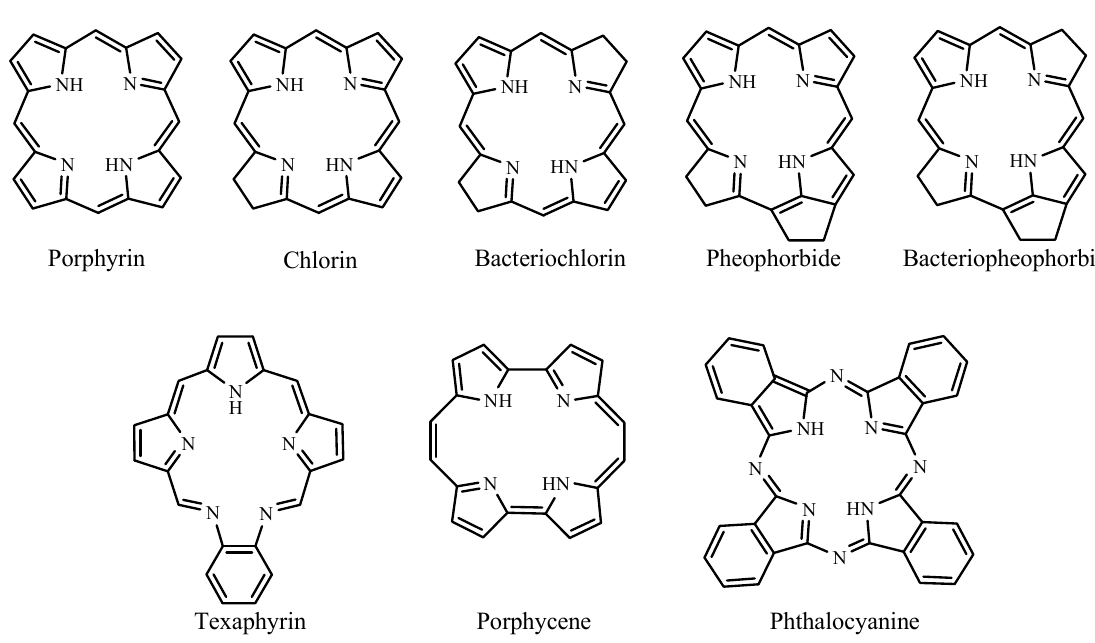
Figure 2. Basic structures of porphyrinoid